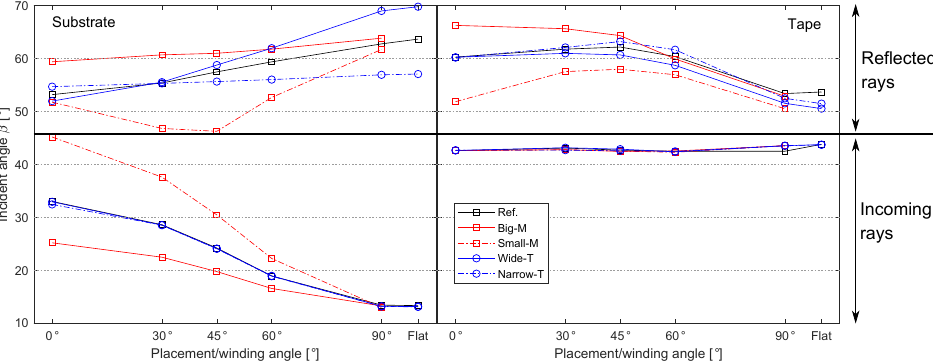
Figure 11. The mean of β distribution on the substrate and tape surfaces for each case study listed in Table